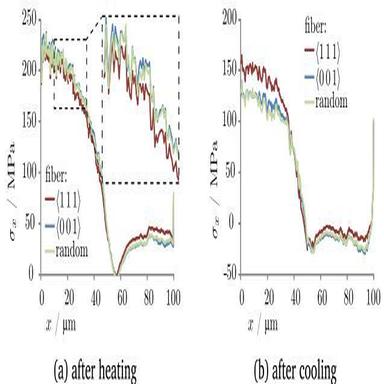
Distribution of the stress in x-direction and the VON MISES stress within the conductor paths after 50 load cycles averaged along the positions depicted in